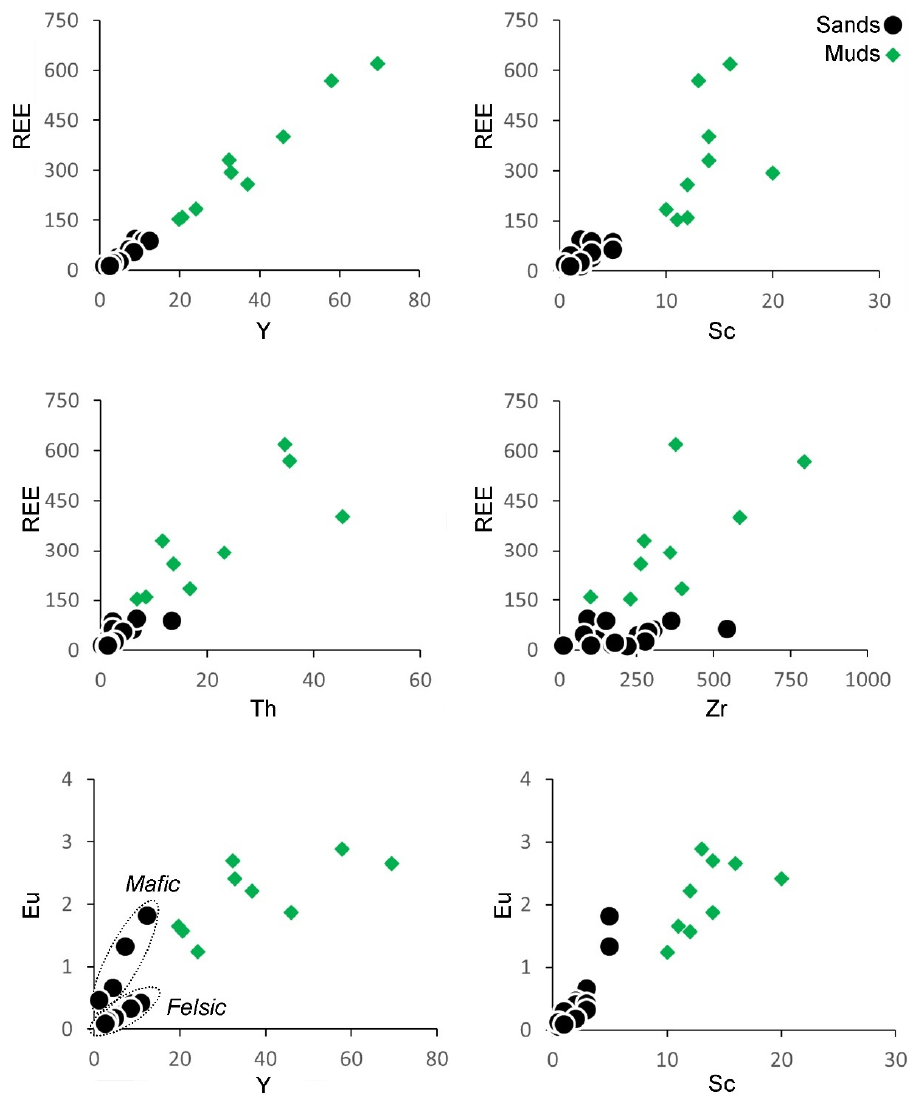
Figure 5. Relation between REE (lanthanides) and Y, Th, Zr, and Sc. The REE patterns are more homogenous in muds than in sands (Figs. 4 and 6). Except for one sample with a mixed provenance that shows anomalously high Gd N /Yb N (6.31 in 37S), REE patterns for sands reveal substantially higher LREE fractionation (3.41 < La N /Sm N < 7.25) than HREE fractionation (0.58 < Gd N /Yb N < 2.19). The Eu anomaly is posi- tive in mafic-derived sands (1.85 < Eu/Eu* < 2.11) and negative in both felsic-derived (0.57 < Eu/Eu* < 0.79) and recycled (0.50 < Eu/Eu* < 0.68) sands (Figure 5). Sands with a mixed mafic–felsic source yield widely variable Eu anomalies (0.47 < Eu/Eu* < 4.03). Samples with distinct source areas do not display substantially different Ce anomalies (0.69 < Ce/Ce* < 1.51), the extremes being measured in sands with a mixed provenance. REE patterns for muds are characterized by slightly higher LREE fractionation (2.39 < La N /Sm N < 5.49) than HREE fractionation (1.33 < Gd N /Yb N < 2.37) (Figure 6). The Eu anom- alies are negative in muds with felsic and recycled sources (0.58 < Eu/Eu* < 0.91), and slightly more variable in muds with mixed sources (0.52 < Eu/Eu* < 1.02). Except for one